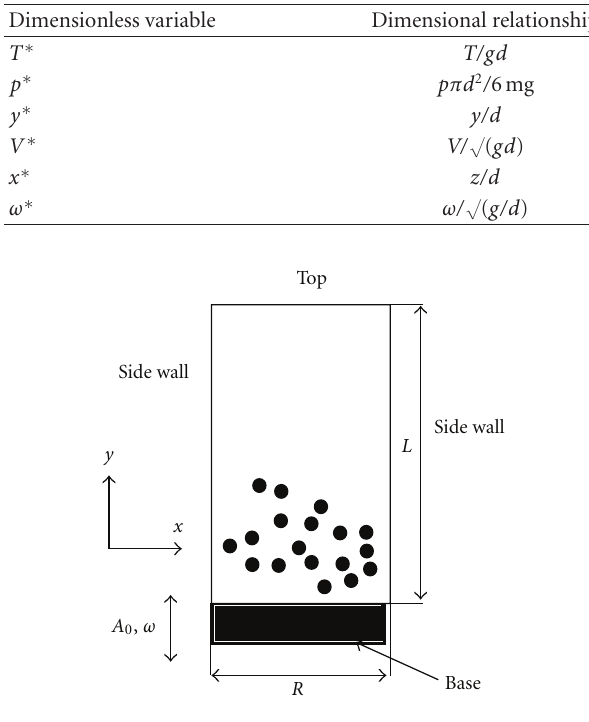
Figure 1: Schematics of the simulation